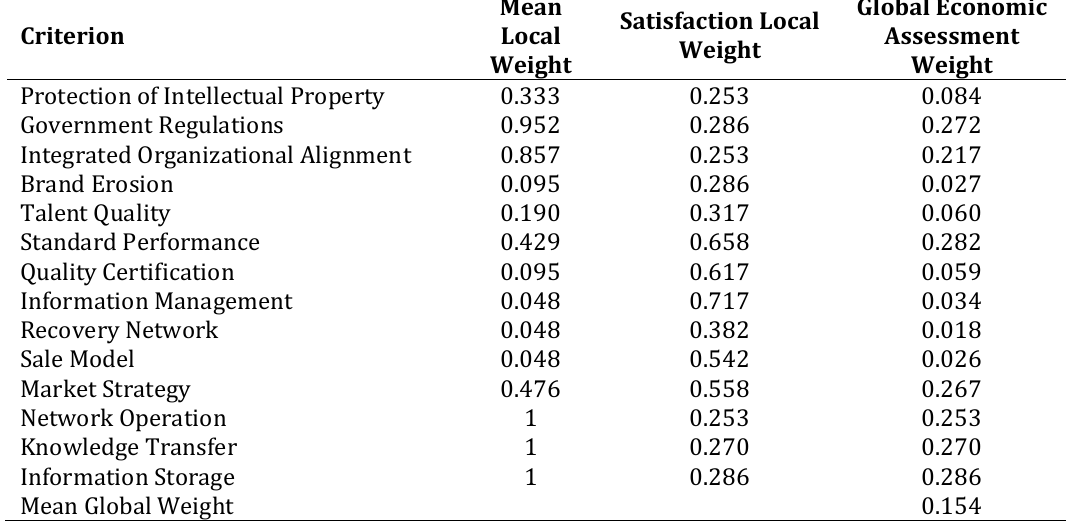
Table 6: Index weight and global weights of management sub-sustainability